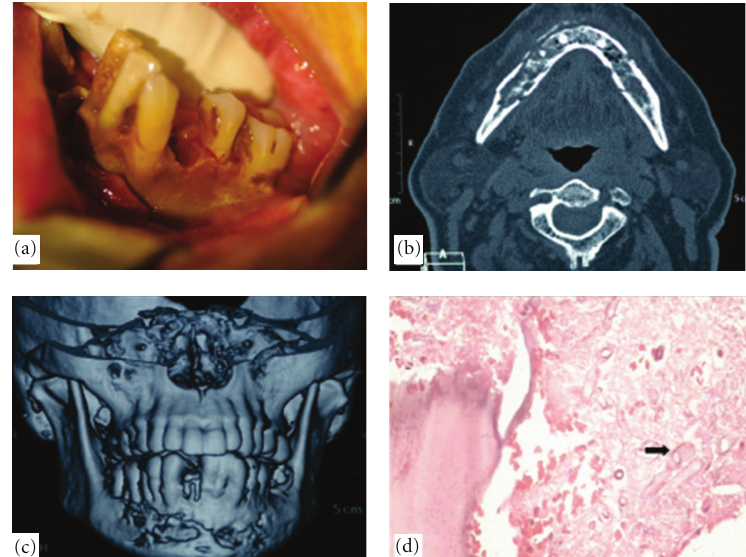
Figure 1: Showing clinical, radiological, and histological features of mandibular osteomyelitis due to mucormycosis. (a) Denuded avascular bone 36 to 32; (b) and (c) CT scan showing osteolysis of buccal and lingual cortices, loss of trabecular bone pattern, evidence of sequestra, and extent of mandibular involvement crossing midline; (d) photomicrograph showing broad fungal hyphae (black arrow) (Hematoxylin- Eosin stain, original magnification ×